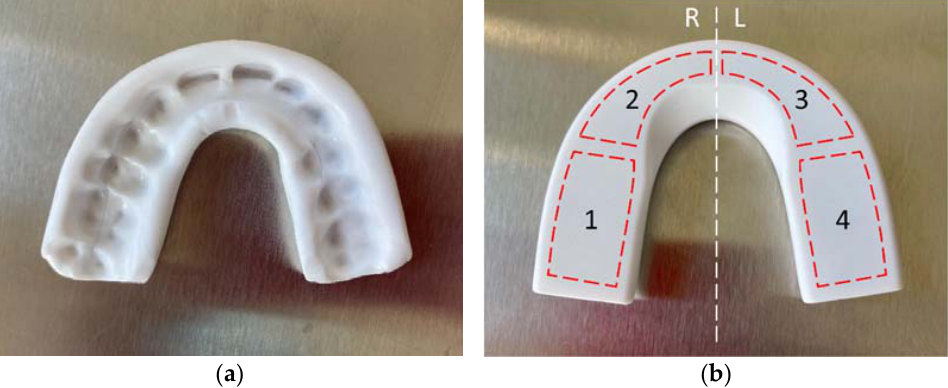
Figure 1. The AesyBite Discover oral appliance. ( a ) Top view showing the maxillary arch impression. ( b ) Occlusal plane view (R: right side, L: left side) with superimposed position of the four pressure sensors (1–4) hidden in the appliance.